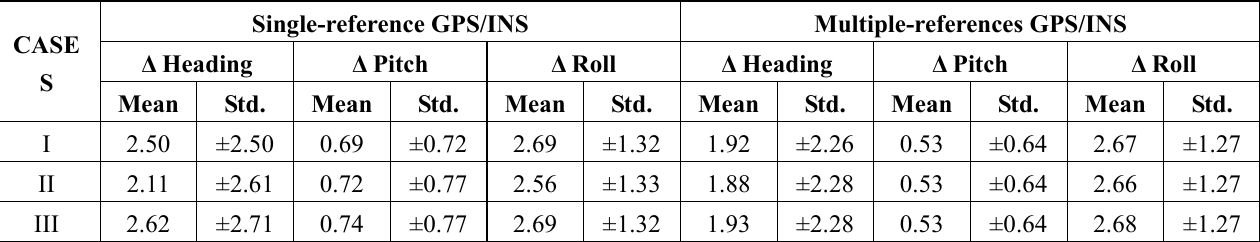
Table 3. Statistical summary of the attitude parameter differences between the references and estimates (unit: